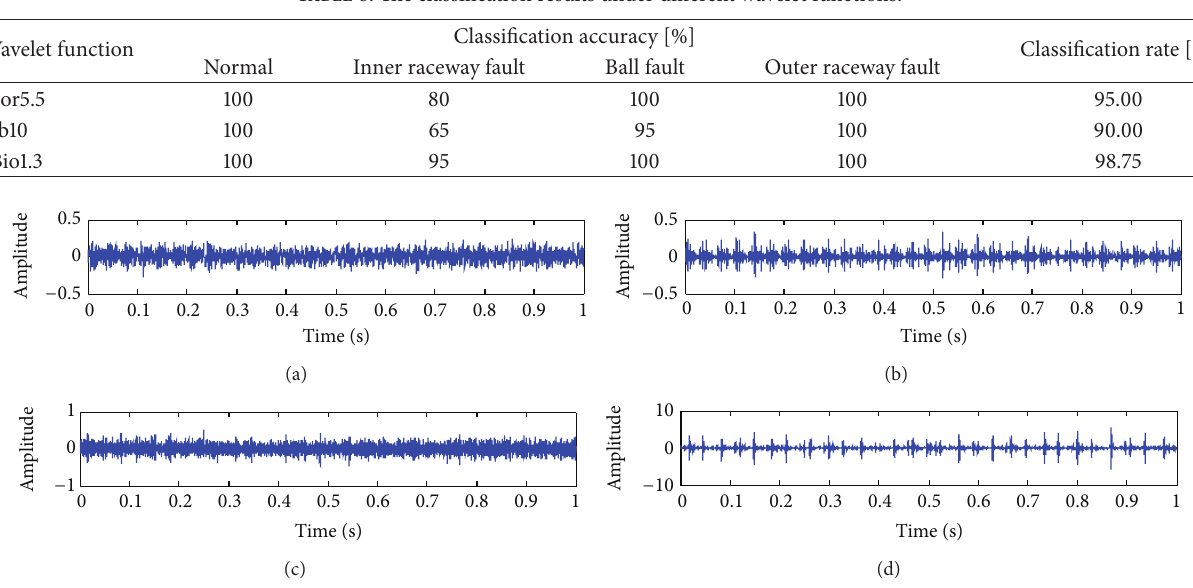
Figure 7: Vibration signals of bearings with different fault locations under varying load and rotating speed: (a) normal, (b) inner raceway fault, (c) ball fault, and (d) outer raceway fault (fault diameter: 0.53